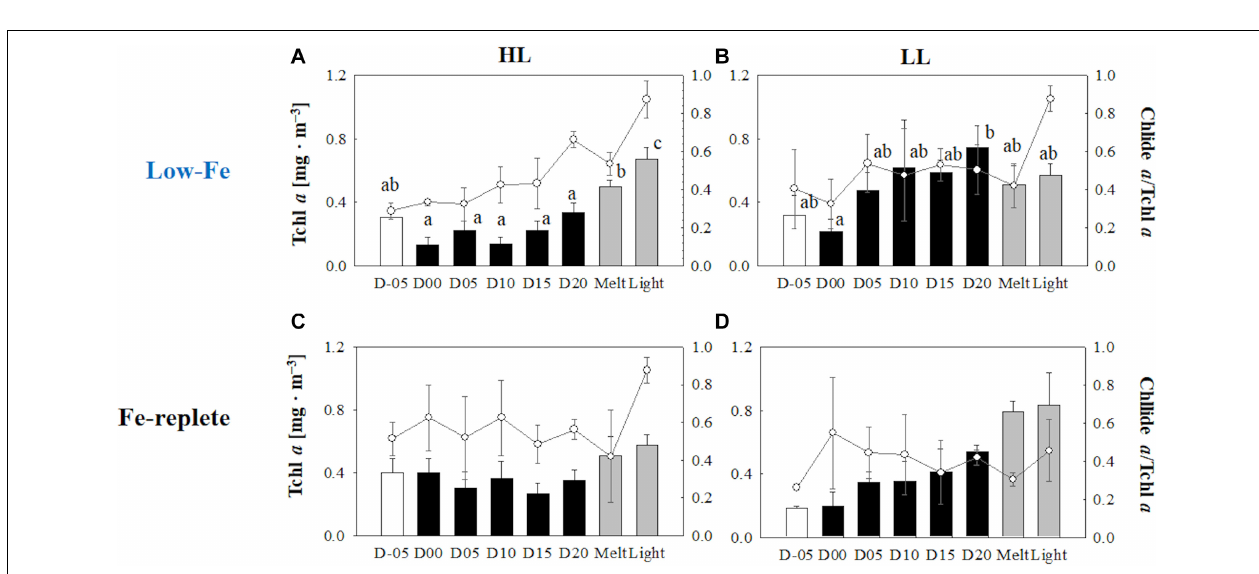
FIGURE 9 | Total chlorophyll a (Tchl a ) concentrations contributions of chlide a to Tchl a at each sampling time point during the ice tank incubation experiments. Panels (A,B) show Tchl a concentrations (bars, left axis) and contributions of chlide a to Tchl a (open circles, right axis) of the low-Fe ice tank runs in this study, whereas panels (C,D) show those of Fe-replete ice tank runs modified from Yoshida et al. (2020). Left (A,C) and right (B,D) panels indicate data from the HL and LL treatments, respectively. Open, closed, and shaded bars indicate values of pre-freeze seawater, ice, melted seawater samples, respectively. Letters above bars in a panel indicate significant differences in values between sampling days and light treatments with one-way ANOVA with Tukey’s test; there is no significant difference between values if a given letter is shown in the combination of letters of the counterparts. The D stands for “day,” while Melt and Light indicate values after melting and light exposure experiments, respectively. Error bars show 1 standard deviation ( n = 3). Tchl a : One-way ANOVA with Tukey’s test, HL: F ( 7 , 23 ) = 24.17, p < 0.001; LL: F ( 7 , 23 ) = 2.78, p = 0.48; Two-way ANOVA with Tukey’s test, Light: F ( 1 , 46 ) = 19.44, p < 0.001; Day: F ( 7 , 46 ) = 5.68, p < 0.001; Light*Day: F ( 7 , 46 ) = 2.15, p > 0.05. Chlide a /Tchl a : One-way ANOVA with Tukey’s test, HL: F ( 7 , 23 ) = 18.40, p < 0.001; LL: F ( 7 , 23 ) = 3.53, p = 0.017. Two-way ANOVA test with Tukey’s test, Light: F ( 1 , 46 ) = 1.71, p > 0.05; Day: F ( 7 , 46 ) = 9.29, p < 0.001; Light*Day: F ( 7 , 46 ) = 2.40, p > 0.05. The results of Tukey’s test, as q -values, are given in the